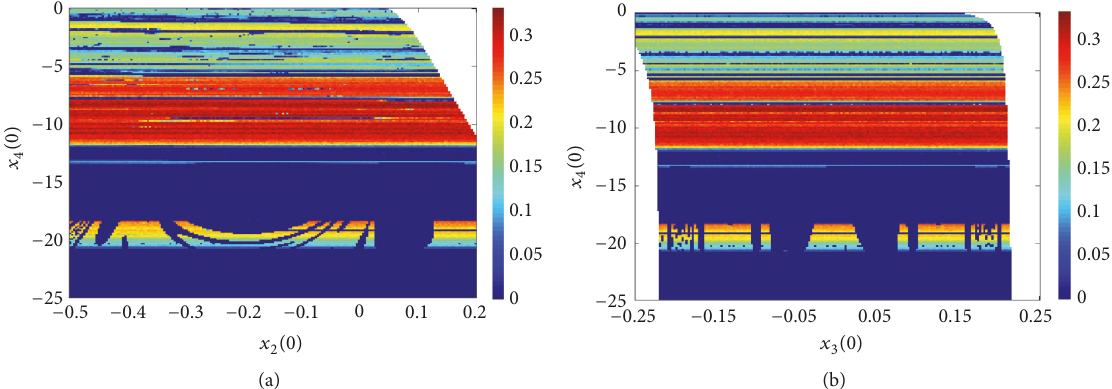
Figure 11: Extreme multistability of the 4D system (1) demonstrated by two-parameter plots in the initial spaces. (a) Two-parameter plot in the x 2 (0)- x 4 (0) plane with x 1 (0) = 0 and x 3 (0) = 0.2. (b) Two-parameter plot in the x 3 (0)- x 4 (0) plane with x 1 (0) = 0 and x 2 (0) = 0.1.